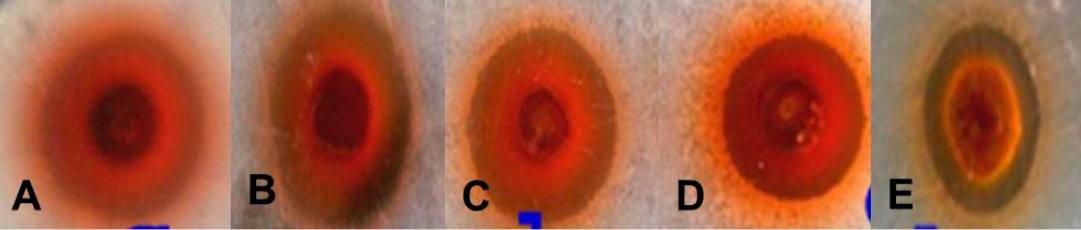
Figure 8. Antibacterial activities of AgNPs synthesized by G. sessiliforme (volume-50 µL/well): ( A ) M. luteus ; ( B ) L. innocua ; ( C ) B. subtilis ; ( D ) S. faecalis ; ( E ) E. coli .